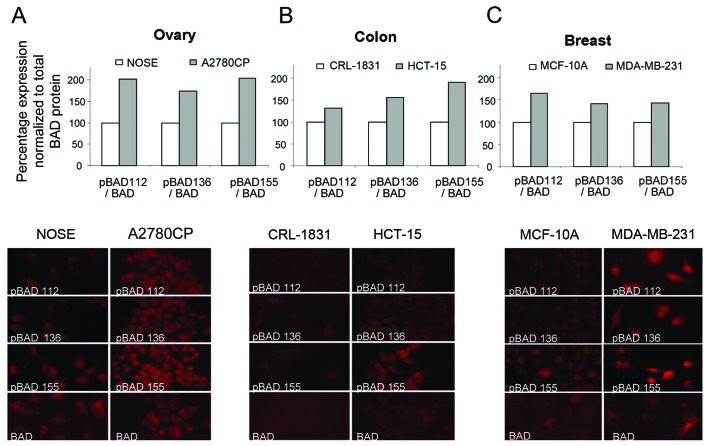
Phosphorylated BAD (pBAD) isoforms are expressed at higher levels in cancer cells. Immortalized normal and cancer cell line pairs were evaluated for pBAD (serine-112, -136 and -155) levels by immunofluorescence. Image analysis of fluorescence intensity indicated that cancer cells of the (A) ovary, (B) colon, and (C) breast expressed higher percentages of pBAD (serine-112, -136 and -155) to total BAD protein than the paired immortalized normal cell line. Bar graphs show pBAD-to-total BAD ratios of at least 50 cells per condition depicted as the percentage expression in cancer cells relative to immortalized normal cells. NOSE, normal ovarian surface epithelial.